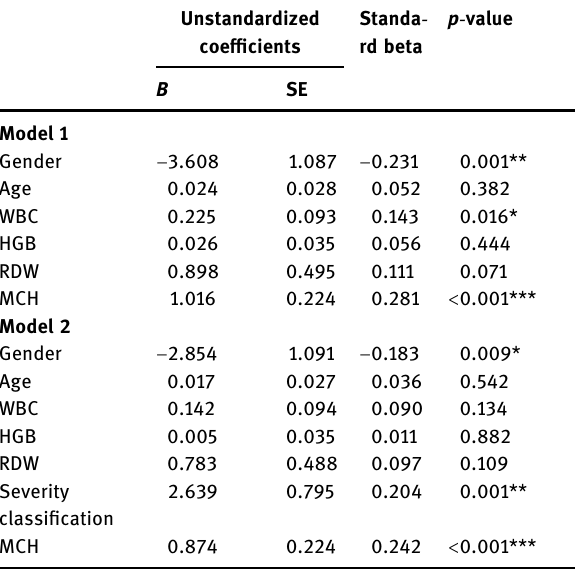
Table 4: The factors related to length of hospital stay in patients with AP in multivariable linear regression